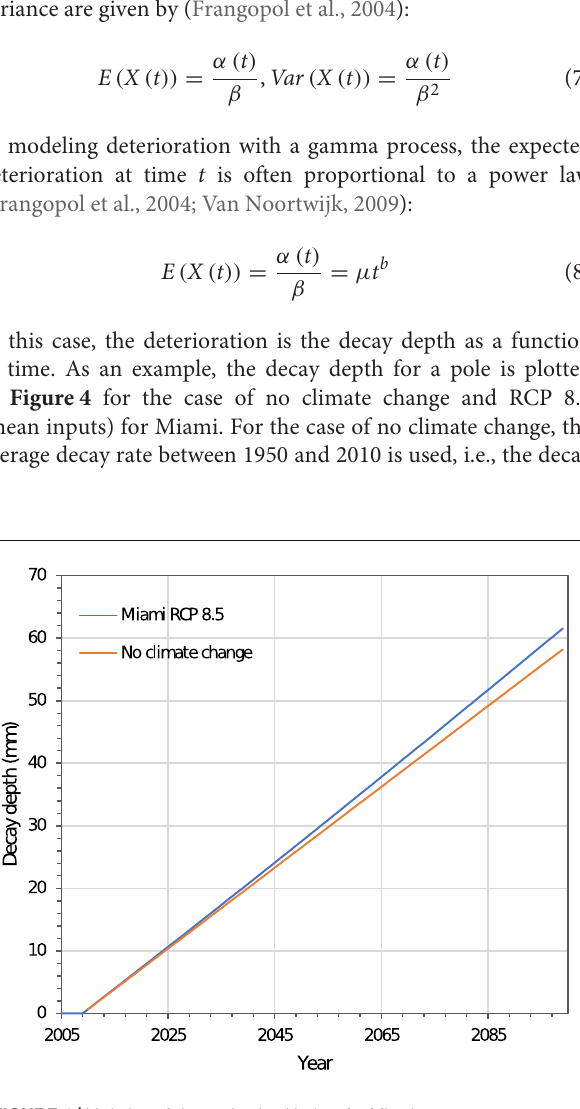
FIGURE 4 | Variation of decay depth with time for